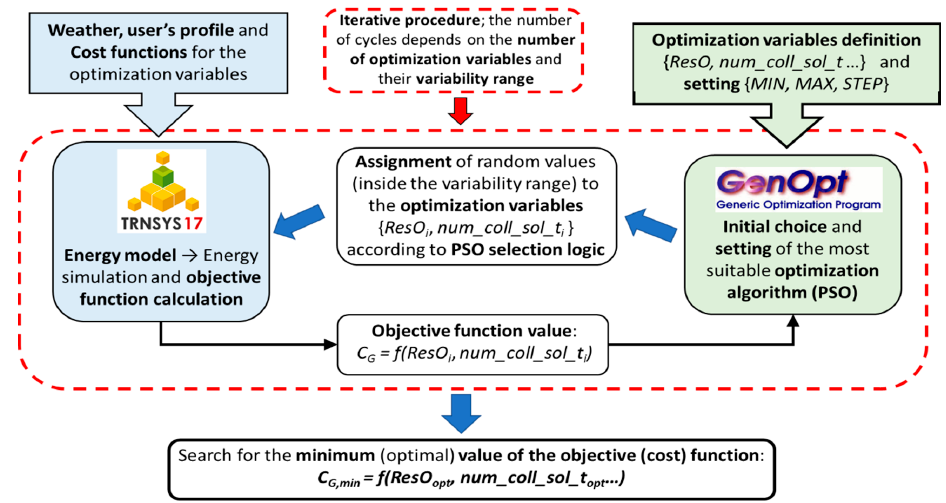
Figure 3. Schematic for the optimization process.